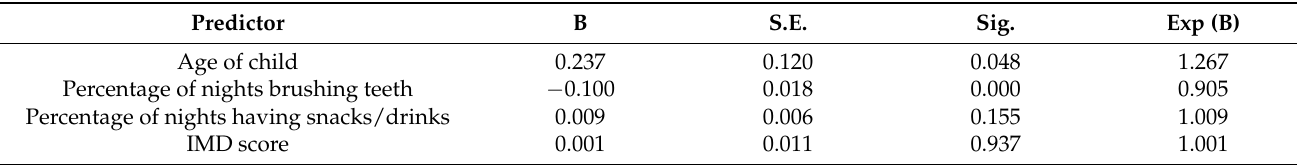
Table 2. Binary logistical regression